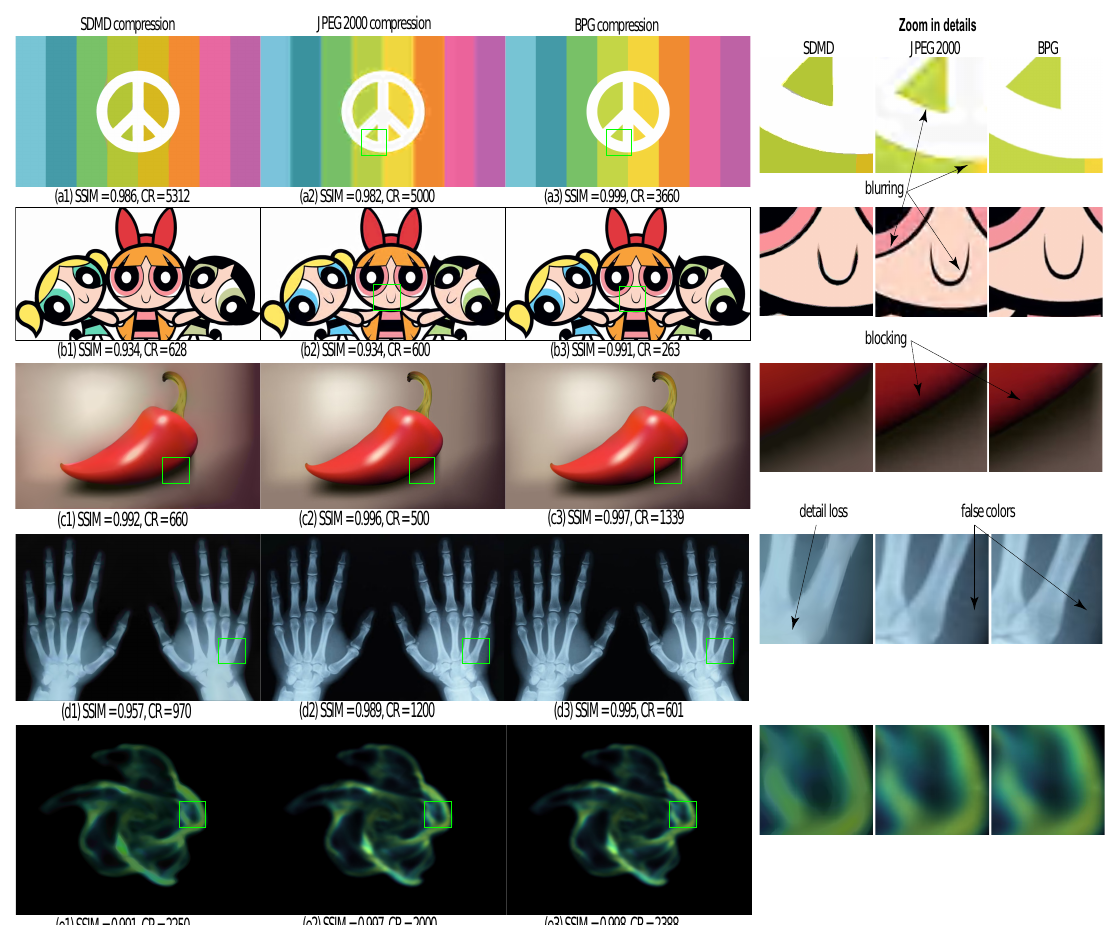
Figure 15. A comparison of SDMD ( a1–e1 ) with JPEG 2000 ( a2–e2 ) and BPG ( a3–e3 ) for 5 input images, one of each type in Table 1. For each result, we show the SSIM quality Q and compression ratio CR. The right three columns show selected areas zoomed in on the three images in the same row to the left, for detailed